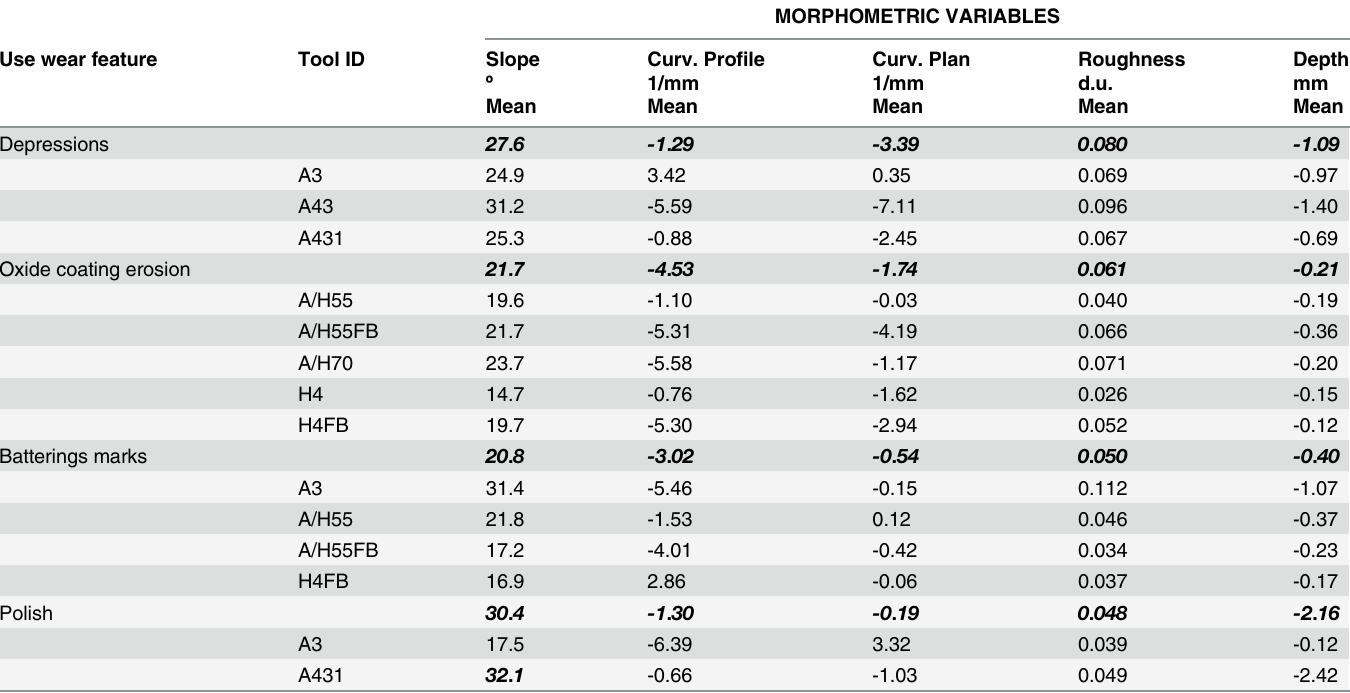
MORPHOMETRIC VARIABLES